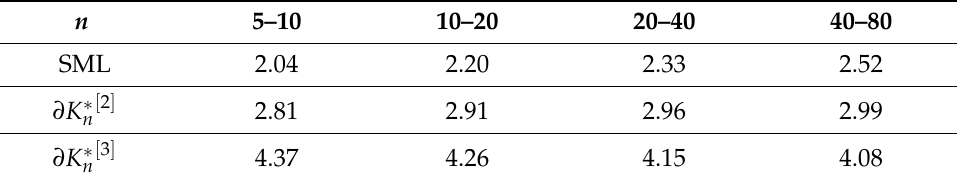
Figure 1. Semilinear equation with f ( t , u ) = u 2 + h ( t ) and GRK4T integrator, with Dirichlet bound- ary conditions. Table 1. Orders for global error, GRK4T and f ( t , u ) = u 2 + h ( t ) with Dirichlet boundary conditions. SML stands for ‘standard method of lines’ and ∂ K ∗ n [ 2 ] , ∂ K ∗ n [ 3 ] for the different variations of the technique suggested in this